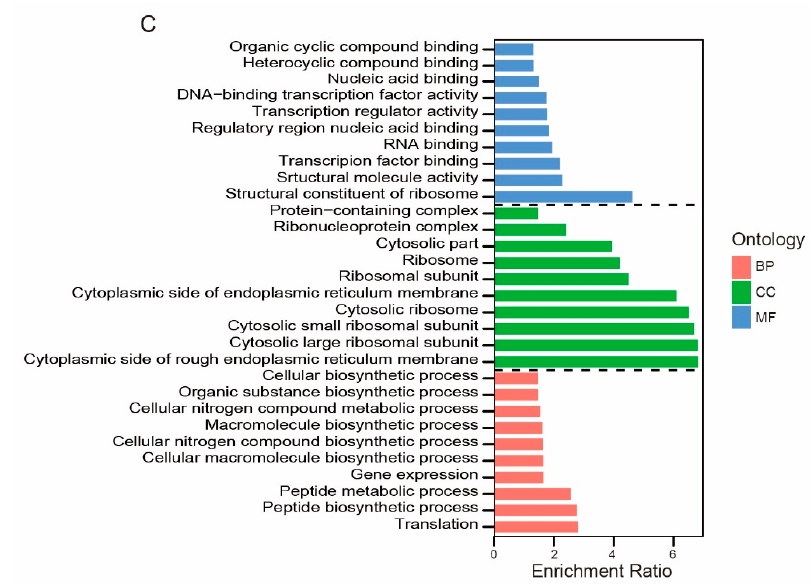
Figure 2. Di ff erentially expressed genes (DEGs) and GO enrichment analysis. ( A ) Volcano plot for DEGs between early-dividing and late-dividing pig SCNT 2-cell embryos (FDR < 0.05 and | log2 (fold change) | > 1); the upregulated genes (highly-expressed in early-dividing embryos) are represented by red dots and the downregulated genes (highly-expressed in late-dividing embryos) are represented by green dots. ( B , C ) GO functional enrichment analysis of the upregulated DEGs ( B ) and downregulated DEGs ( C ). The top 10 biological processes (BPs), cellular components (CCs) and molecular function (MF) terms were listed.